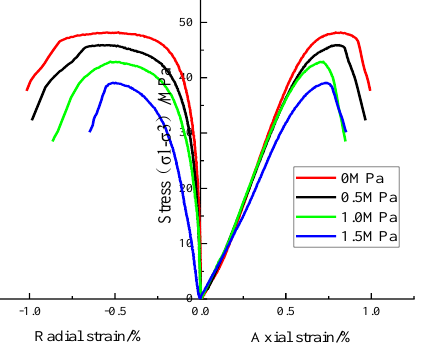
Figure 4. Triaxial stress – strain curves under different seepage pressures.